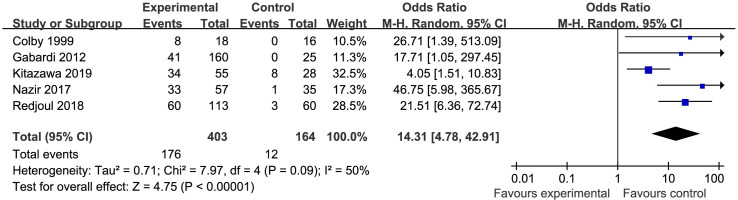
Forest plot of the rate of drug discontinuation.The vertical line indicates no difference between the groups. ORs are represented by diamonds, and 95% CIs are depicted by horizontal lines. Squares indicate point estimates, and the size of each square indicates the weight of the given study in the meta-analysis. M-H, Mantel-Haenszel random-effects model.